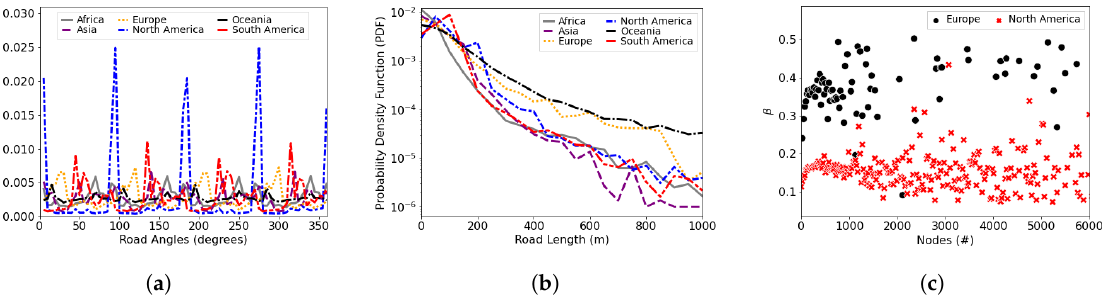
Figure 2. ( a , b ) show the PDF of the road angles and road lengths for different worldwide cities, respectively. ( c ) shows the α and β values for different sized cities in the EU and